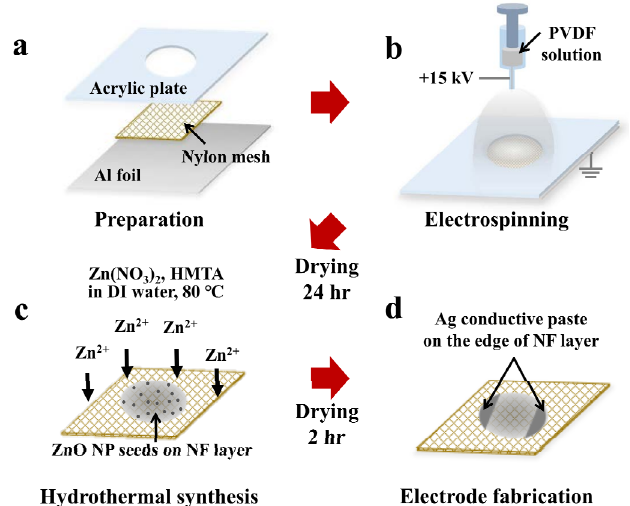
Figure 1. Schematics of the electrospinning, hydrothermal synthesis, and electrode fabrication process: ( a ) Preparation for electrospinning; ( b ) Fabrication of polyvinylidene difluoride nanofiber layer onto the nylon mesh layer; ( c ) Hydrothermal synthesis for ZnO nanowire fabrication after ZnO nanoparticle seeding on PVDF NF layer; ( d ) Electrode coating on smart filter using Ag paste for electrical properties analysis.